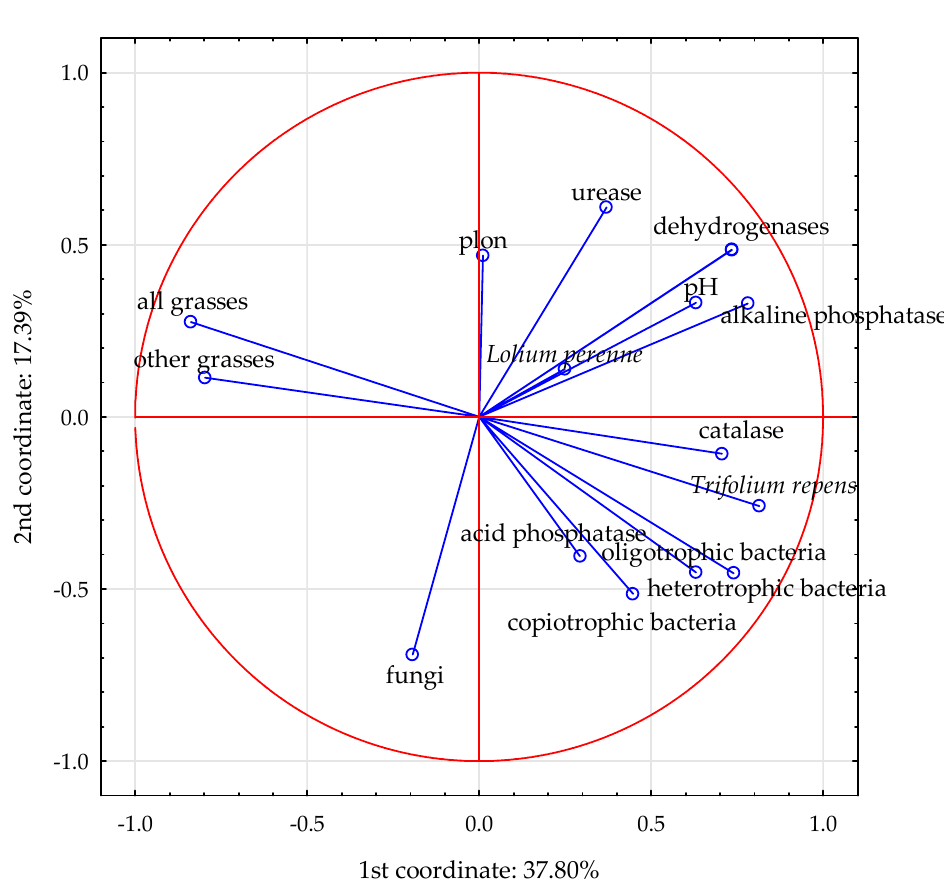
Figure 8. The projection of variables on a plane of the first and second factor—PCA method.